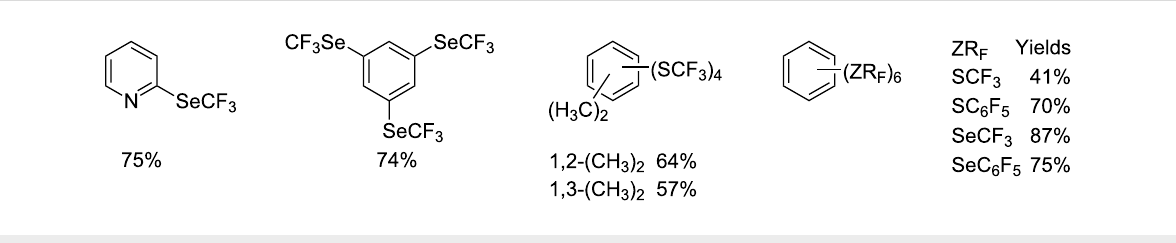
Figure 6: Examples of compounds obtained using in situ generated R F ZCu methodology [94].